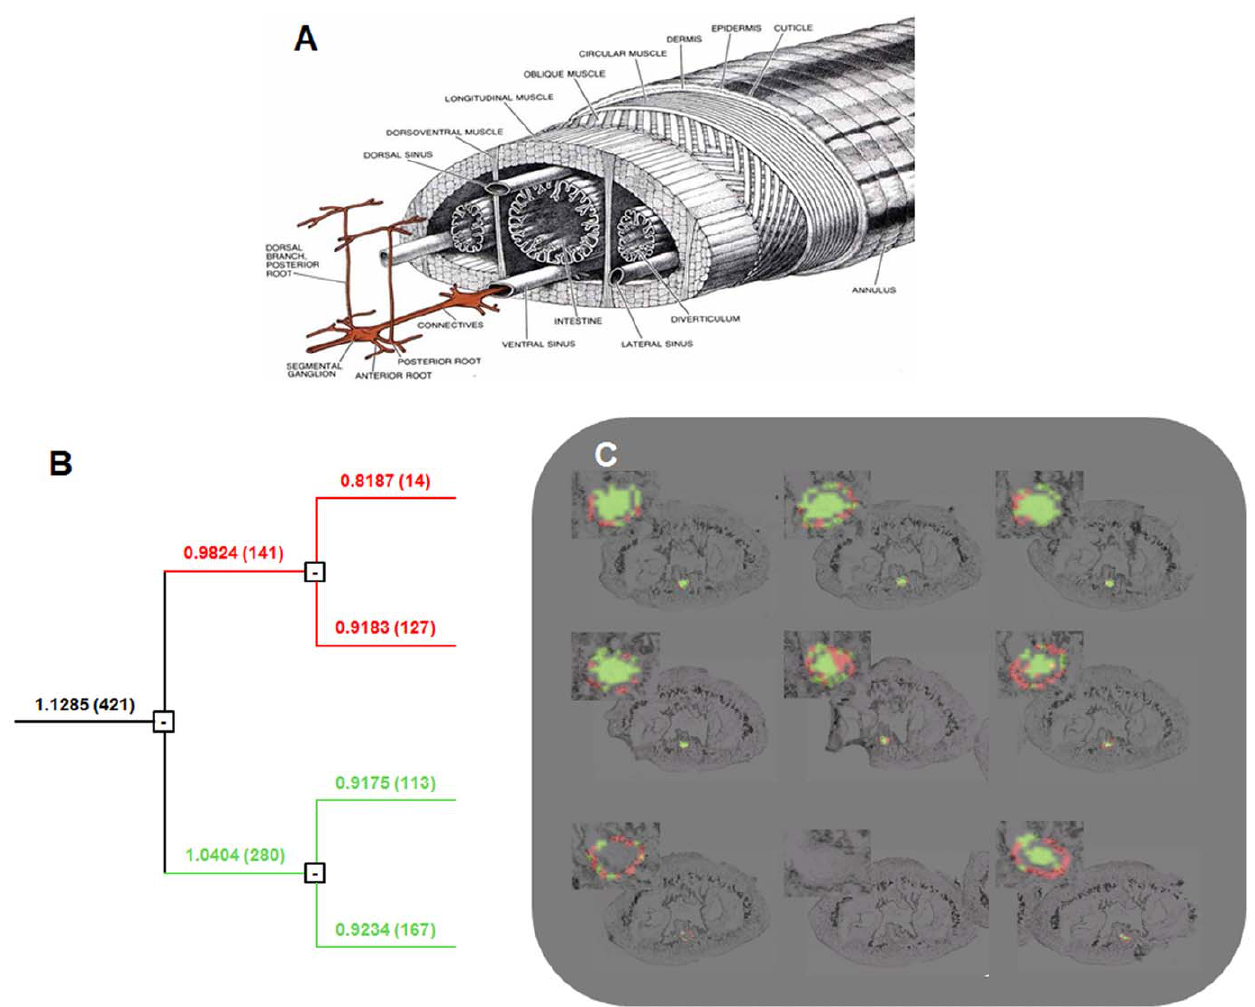
Figure 3. Hierarchical clustering of spectra from 9 sections of a regenerating ganglion and surrounding blood sinus. A . Drawing of the leech structure features the ventral blood sinus surrounding the nerve cord [89]. B . Full dendrogram of all spectra in the ganglion dataset yields two main branches, colored red and green, that segregate into different domains in the images (panel C). C . Reconstruction of selected dendrogram branches and corresponding images shows that the upper branch (red) corresponds mainly with the blood cells (annulus around the central region) while the lower branch (green) corresponds mainly to cells in the CNS region. In some sections, however, cells characterized by the blood sinus peptide profile (red) appear to have migrated into the area of the ganglion (sections 5 and 6 in particular). ( Figure 4 ) represents a peptide sequence related to the intermediate filament gliarin [9], while Peaks 5 and 6 are both related to neurohemerythrin [7]. Neither antimicrobial nor neurotrophic activities were detected for any of these three molecules (data not shown).